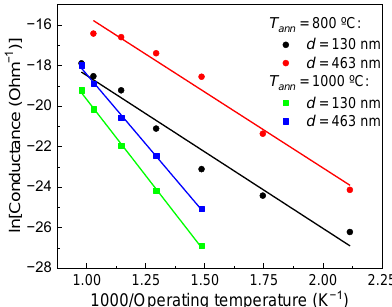
Figure 3. Arrhenius curves for TiO 2 films after annealing at T ann = 800 ◦ C and 1000 ◦ C. The ∆ E d of films annealed at T ann = 800 ◦ C was close to the values for bulk samples obtained by ceramic technology with annealing at 800 ◦ C [51]. The activation energy of films annealed at T ann = 1000 ◦ C coincided with the value of ∆ E d for single-crystal bulk samples obtained by the Verneuil melt method [52]. Such values of ∆ E d are typical for high-temperature treatments, or grown methods, and are caused by the presence of oxygen vacancies in TiO 2 .